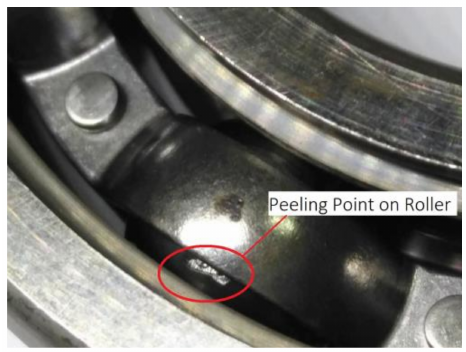
Figure 14. Peeling failure in one bearing ball after running for about 128 h.